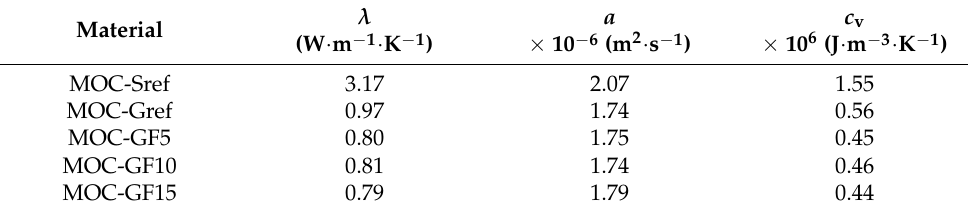
Table 7. Spread diameter and basic macrostructural parameters of developed composites.